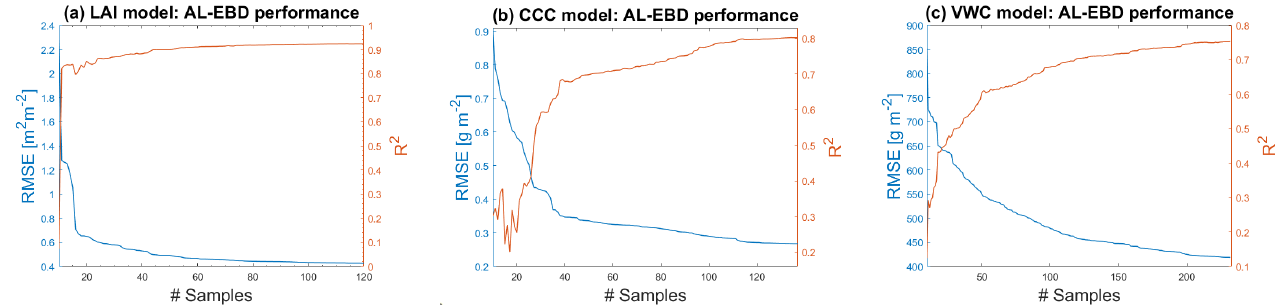
Figure 5. Goodness-of-fit results (RMSE, R 2 ) using AL (EBD) against validation data. ( a ) LAI model; ( b ) CCC model; ( c ) VWC